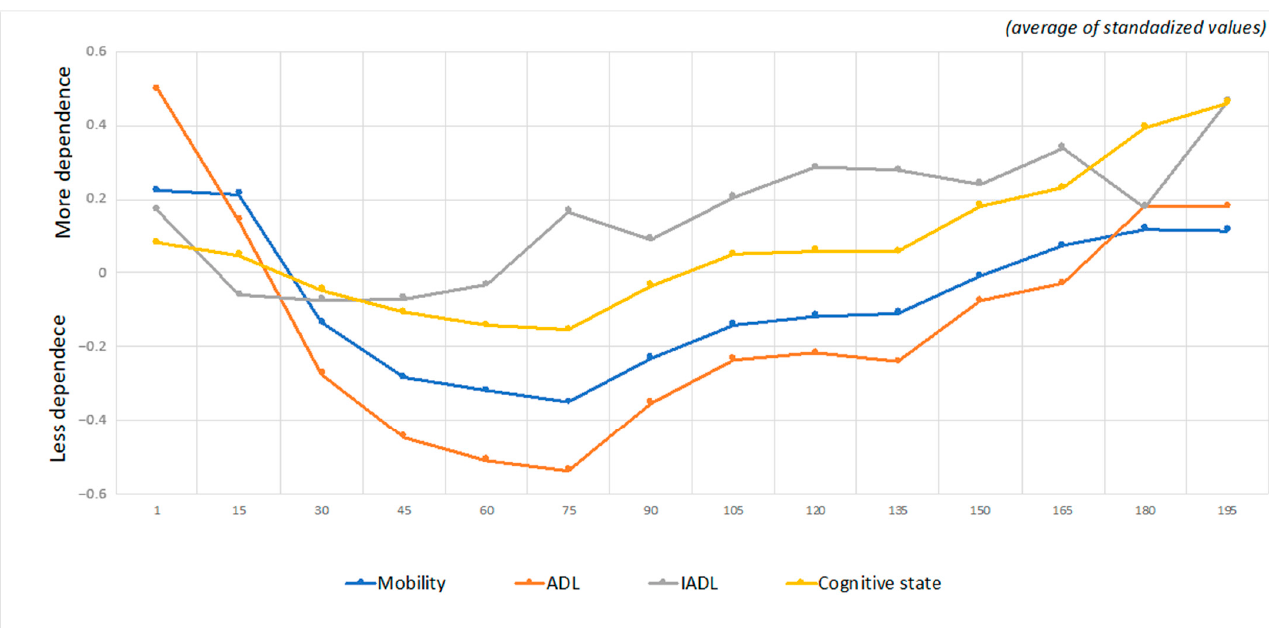
Figure 1. Components: mobility, activities of daily living (ADL), instrumental activities of daily living (IADL) and cognitive status in convalescence units (standardized mean values).